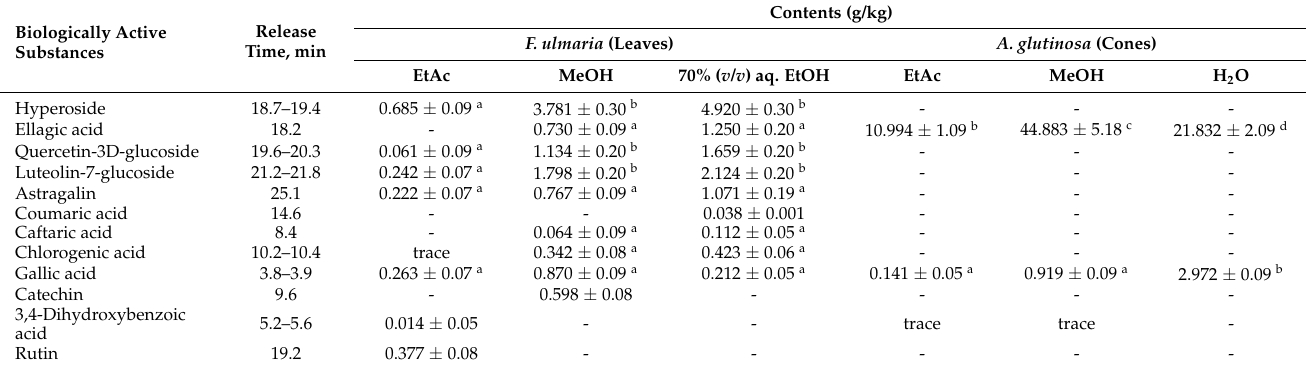
Table 2. The contents of individual phenolic compounds in F. ulmaria and A. glutinosa extracts.